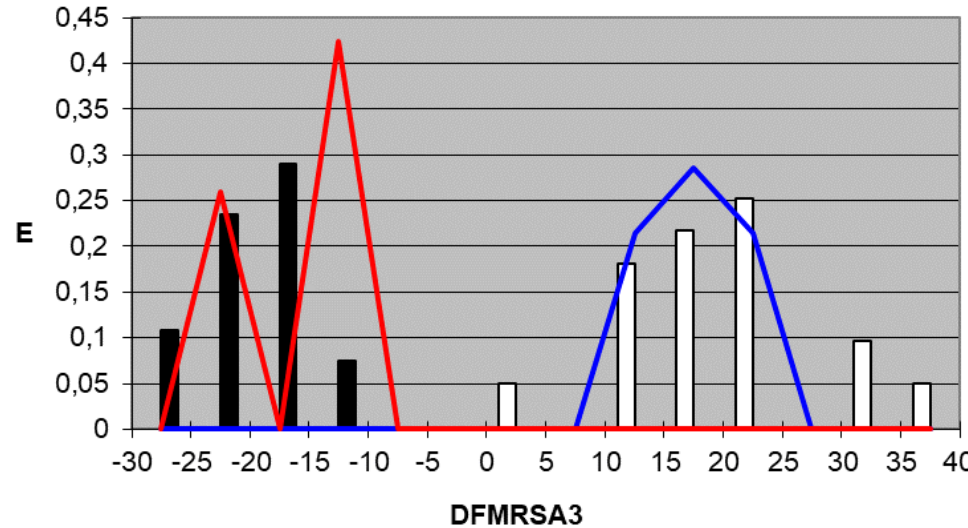
Figure 4. DF MRSA3 pharmacological distribution diagram. Black bars: Training Inactives. White bars: Training Actives. Red curves: Test Inactives. Blue curves: Test Actives.